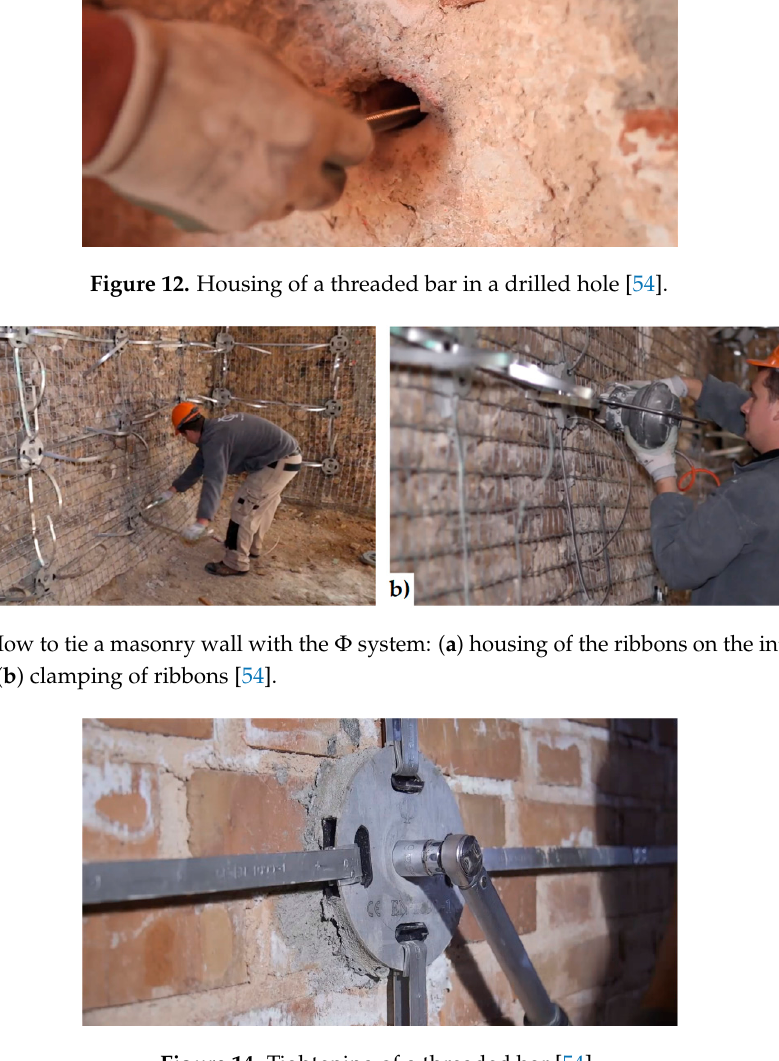
Figure 14. Tightening of a threaded bar [54].